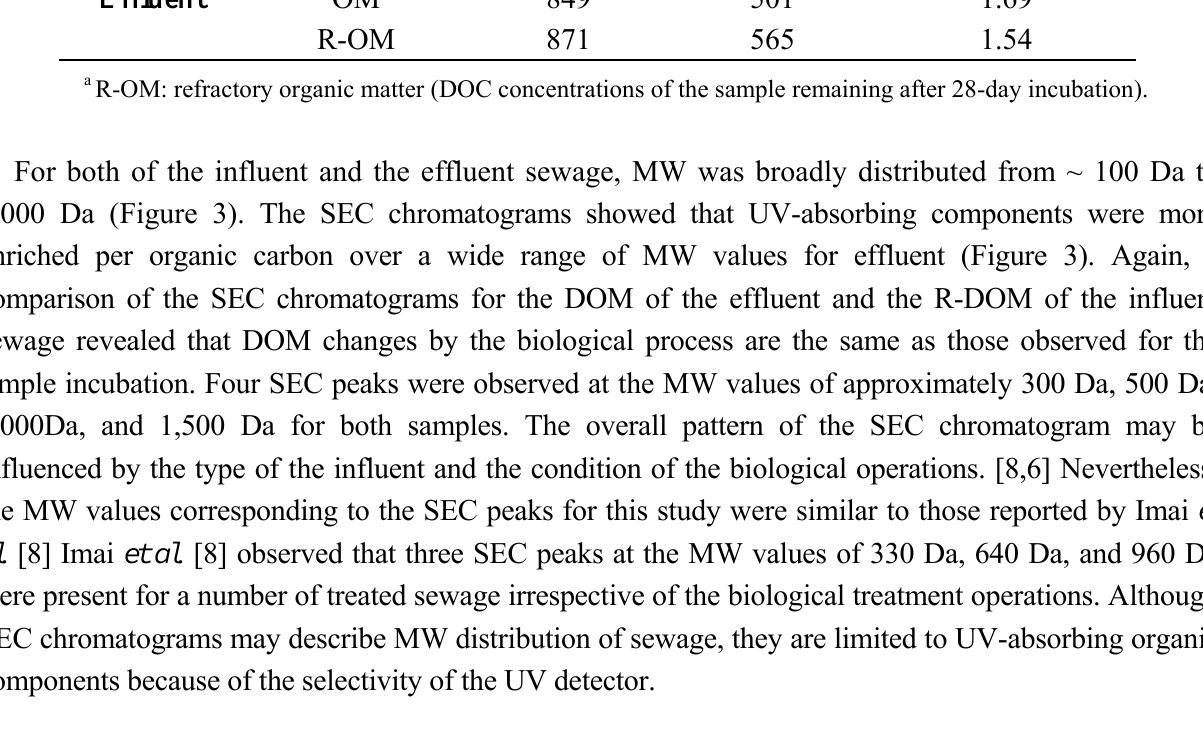
), number-average molecular weight w